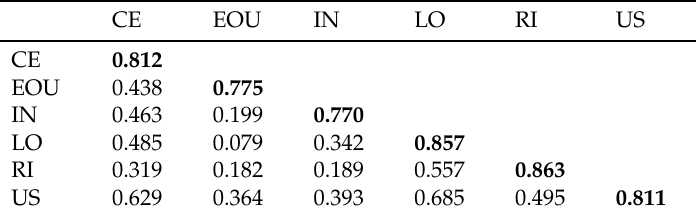
Table 5. Discriminant validity based on Fornell-Larcker’s